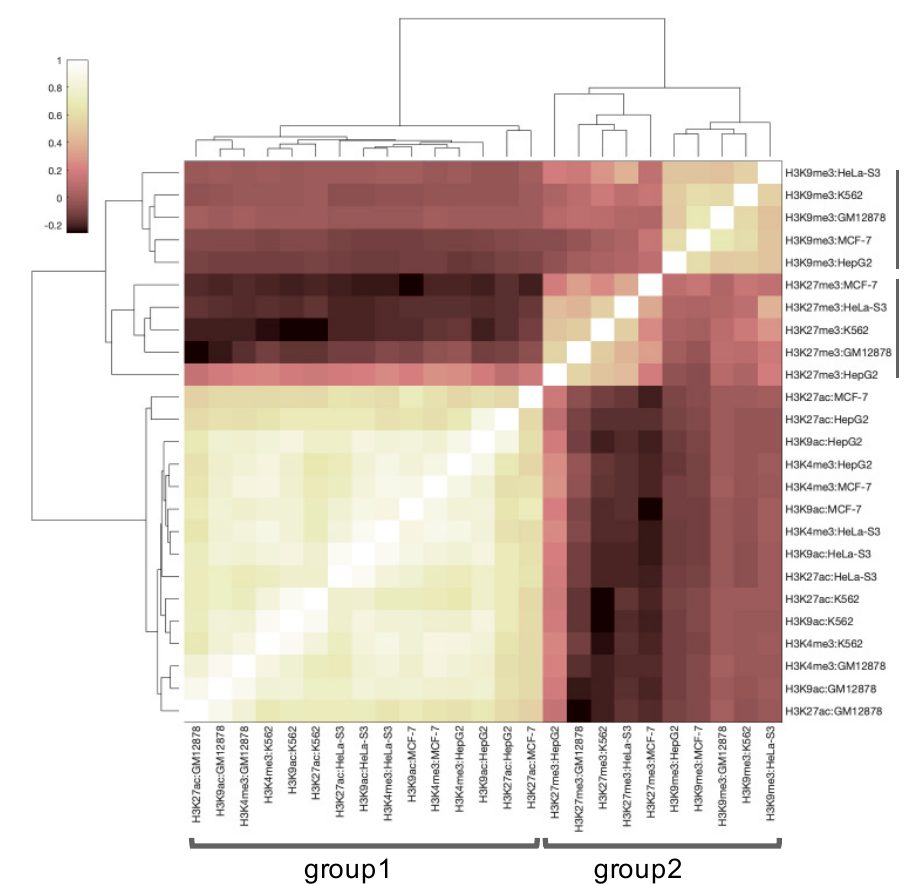
group1 group2 Figure 1. Correlation between profiles of five histone tags ( H3K4me3, H3K9ac , H3K27ac , H3K27me3 and H3K9me3 ) in five human cell lines (K562, GM12878, HepG2, MCF-7, and HeLa-s3).